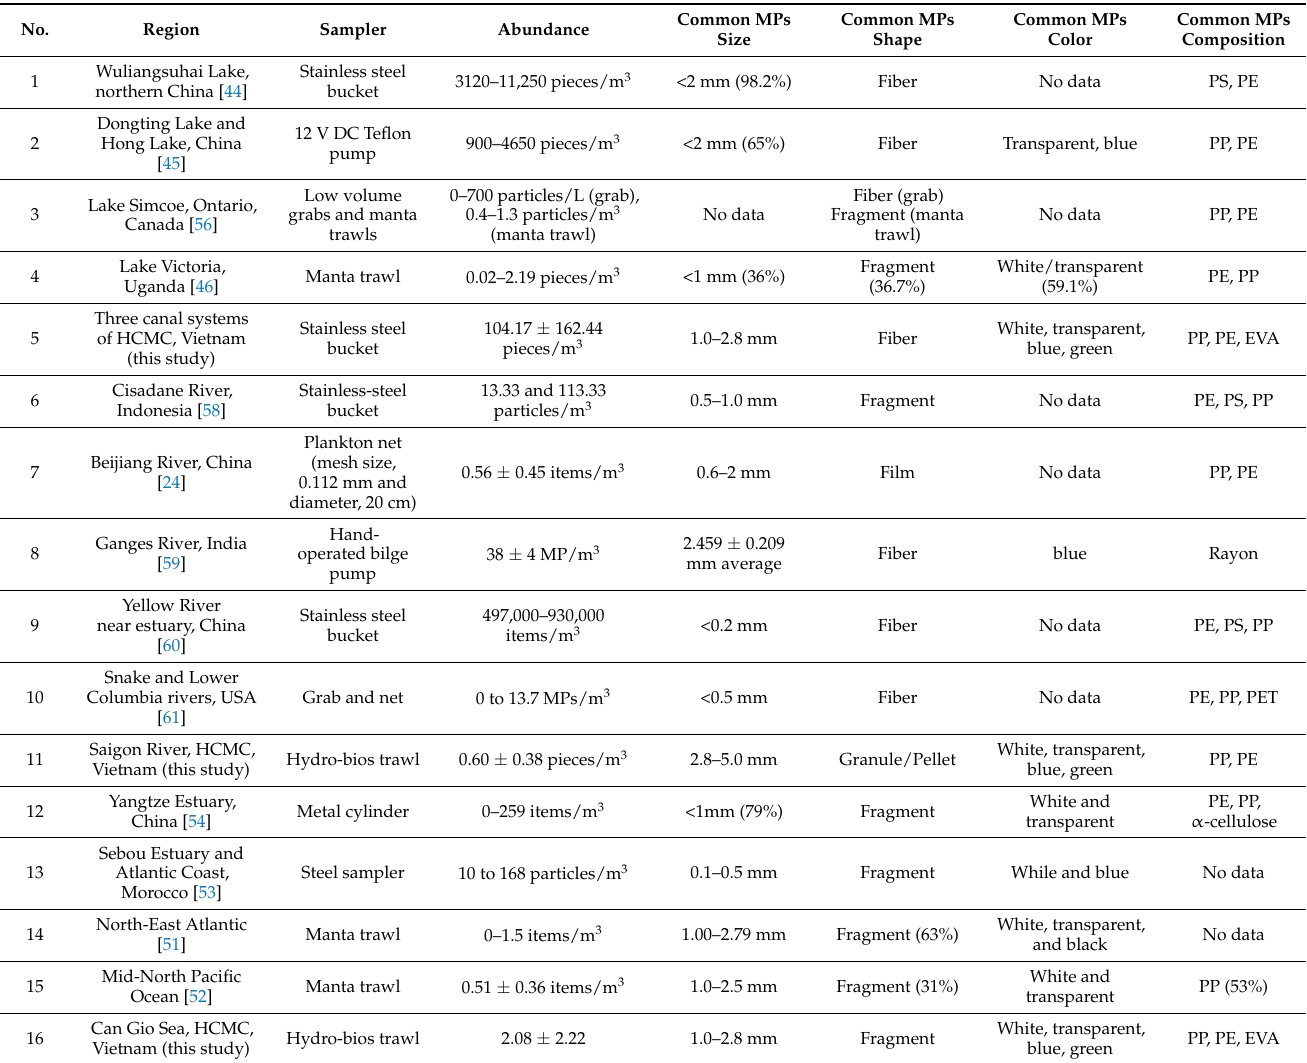
Table 2. Microplastics in surface water of previous